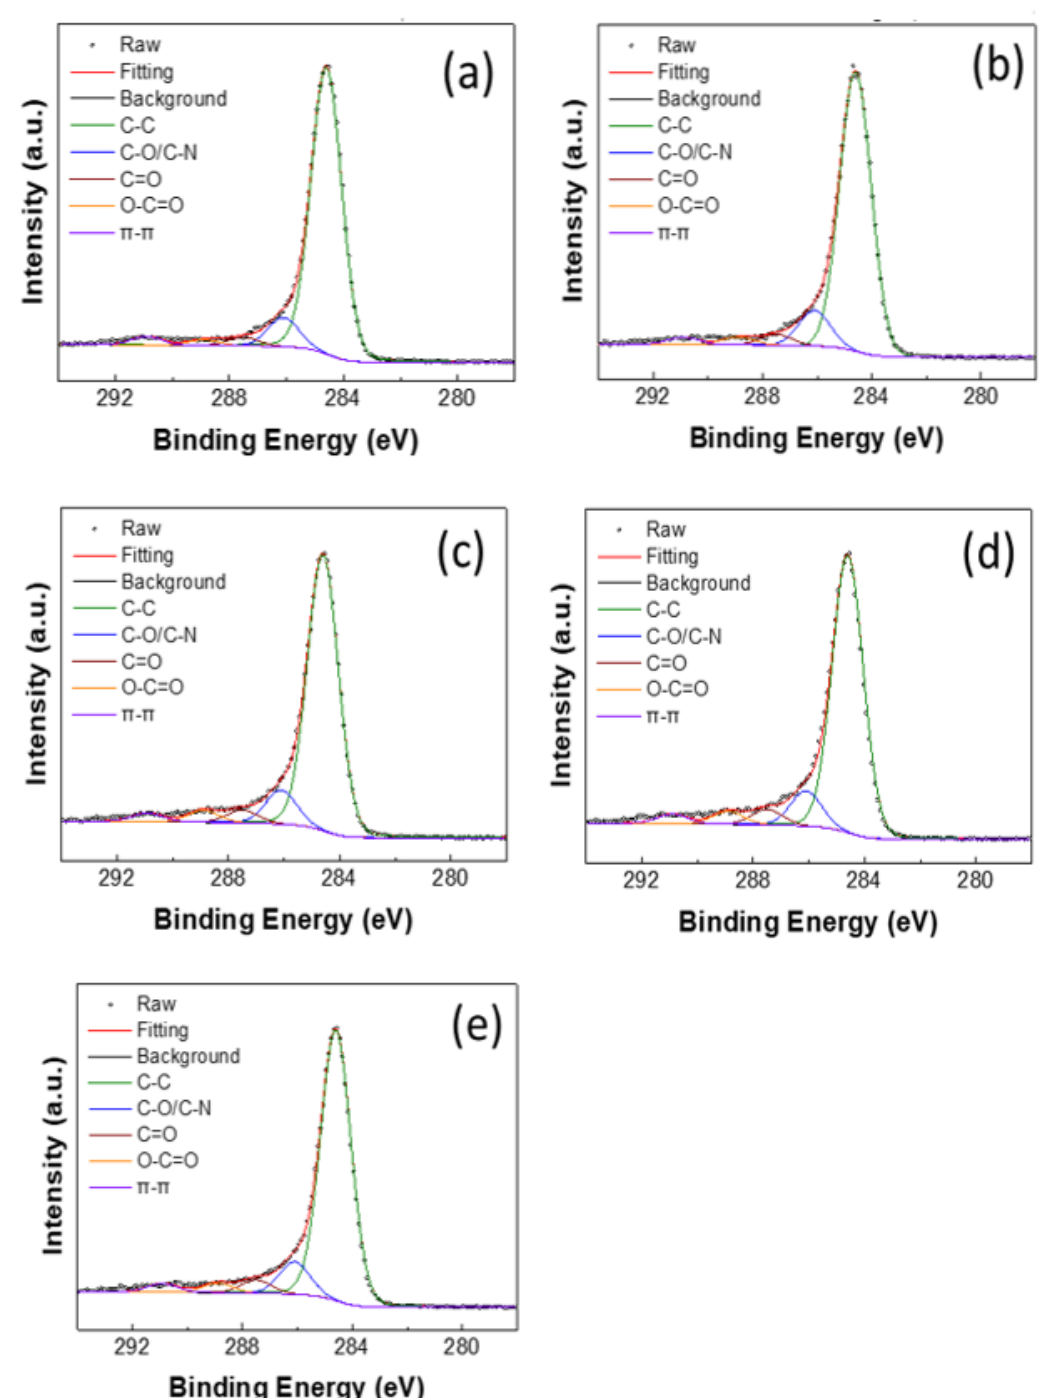
Figure 5. XPS images of GF electrode: ( a ) untreated; ( b ) H 2 SO 4 treatment; ( c ) APPJ 450 °C treatment; ( d ) APPJ 550 °C treatment; ( e ) APPJ 650 °C treatment.